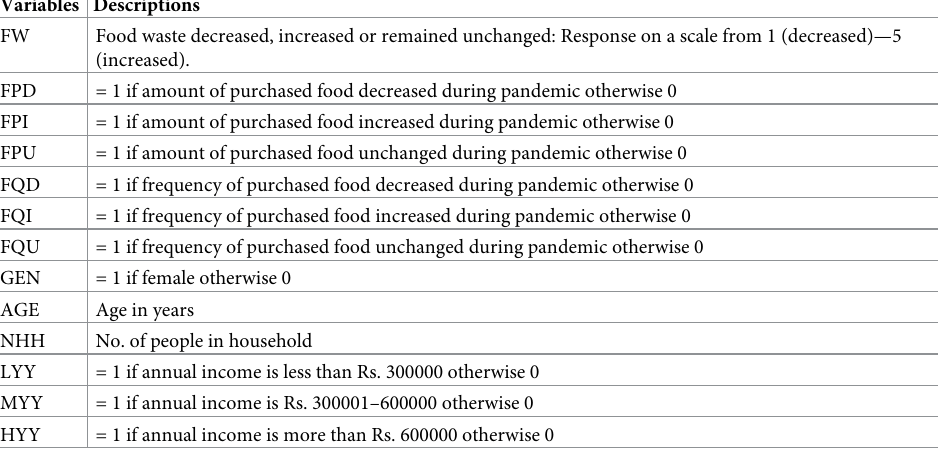
Table 2. Descriptions of